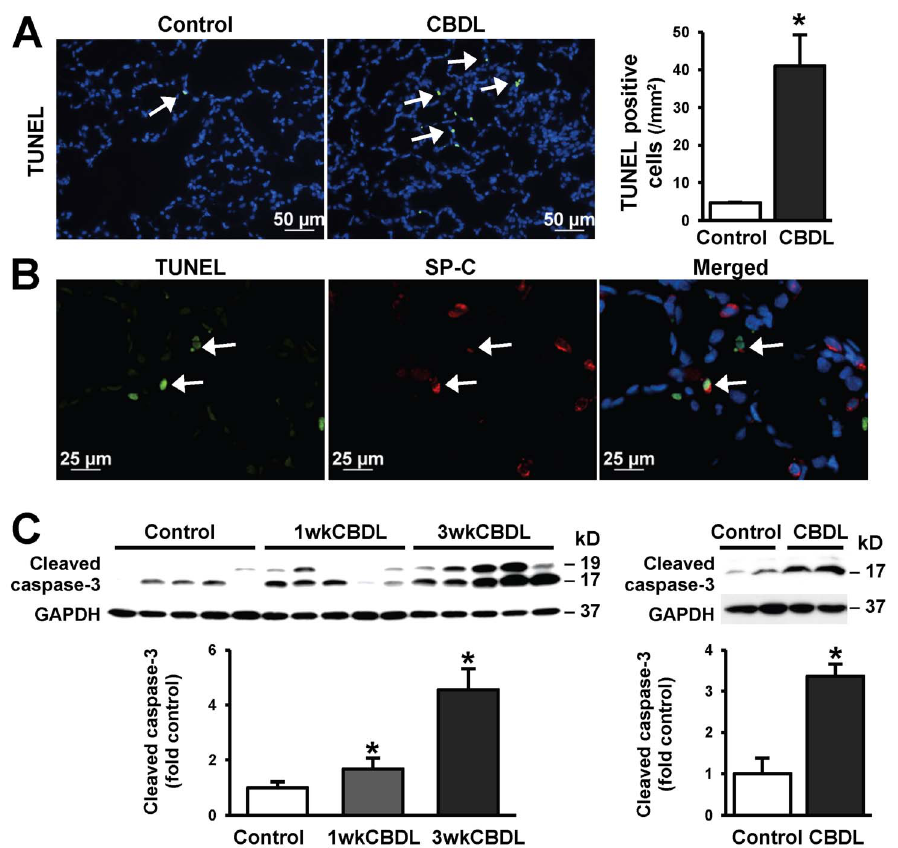
Figure 4. Pulmonary AT2 cell apoptosis after CBDL. ( A ) Representative images of TUNEL staining (green, shown by arrows) and quantitation of TUNEL positive cells in control and 3-week CBDL lung. Scale bar 5 50 m m. ( B ) Immunofluorescence double-labeling of SP-C (red) and TUNEL (green) in alveolar regions of 3-week CBDL animal lung. Apoptotic AT2 cells were marked with arrows. Scale bar 5 25 m m. ( C ) Representative immunoblots and quantitation of cleaved caspase-3 protein levels in control, 1-week and 3- week lung (left), and in isolated AT2 cells from control and 3-week CBDL lung (right). GAPDH was included as a loading control. Cleaved caspase-3 protein levels were normalized to the levels of GAPDH. Relative to control, CBDL lung had increased apoptotic AT2 cells (TUNEL and SP-C double positive). In parallel, cleaved caspase-3 protein levels were upregulated in both CBDL lung homogenates and isolated AT2 cells. Values are expressed as means ¡ SME. * P , 0.05 compared with